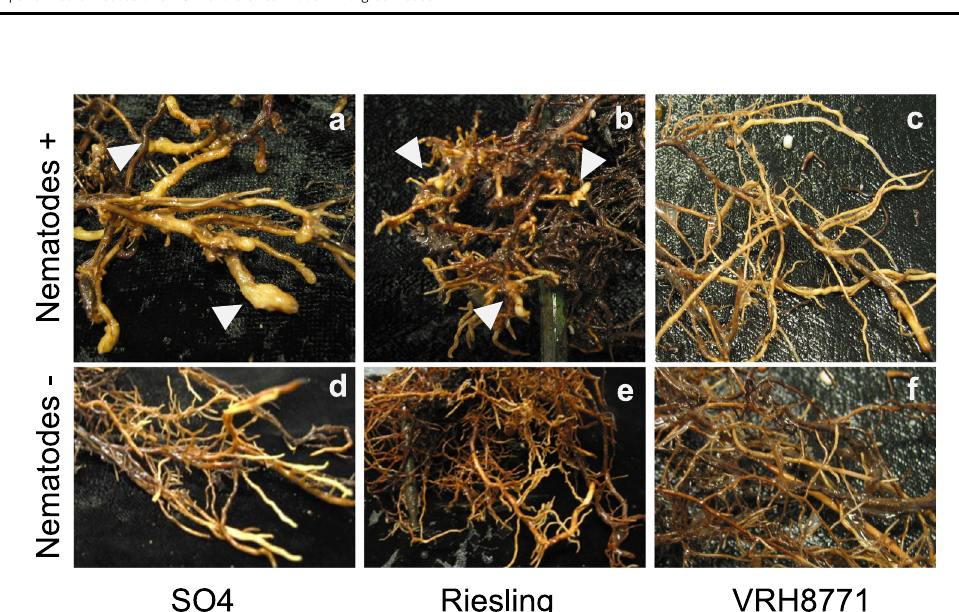
Fig. 1 Impact of X. index feeding on root tips. Root systems of the nematode-susceptible rootstock (SO4; a , d ), the Riesling cultivar ( b , e ) and a nematode- resistant genotype (VRH8771; c , f ) that were exposed to the dagger nematode, X. index , for 8 weeks ( a – c ) or cultivated in soil free of nematodes ( d – f ). The roots of the SO4 and Riesling varieties show terminal galling and swelling (white arrows) caused by X. index . Conversely, no root deformation was observed in the VRH8771 genotype or in the nematode-free (Table 2). These results, obtained in controlled X. index -mediated transmission assays, con fi rmed that the resistance to grapevine fanleaf disease previously observed in Riesling S1 progeny is also expressed in the Riesling variety itself.